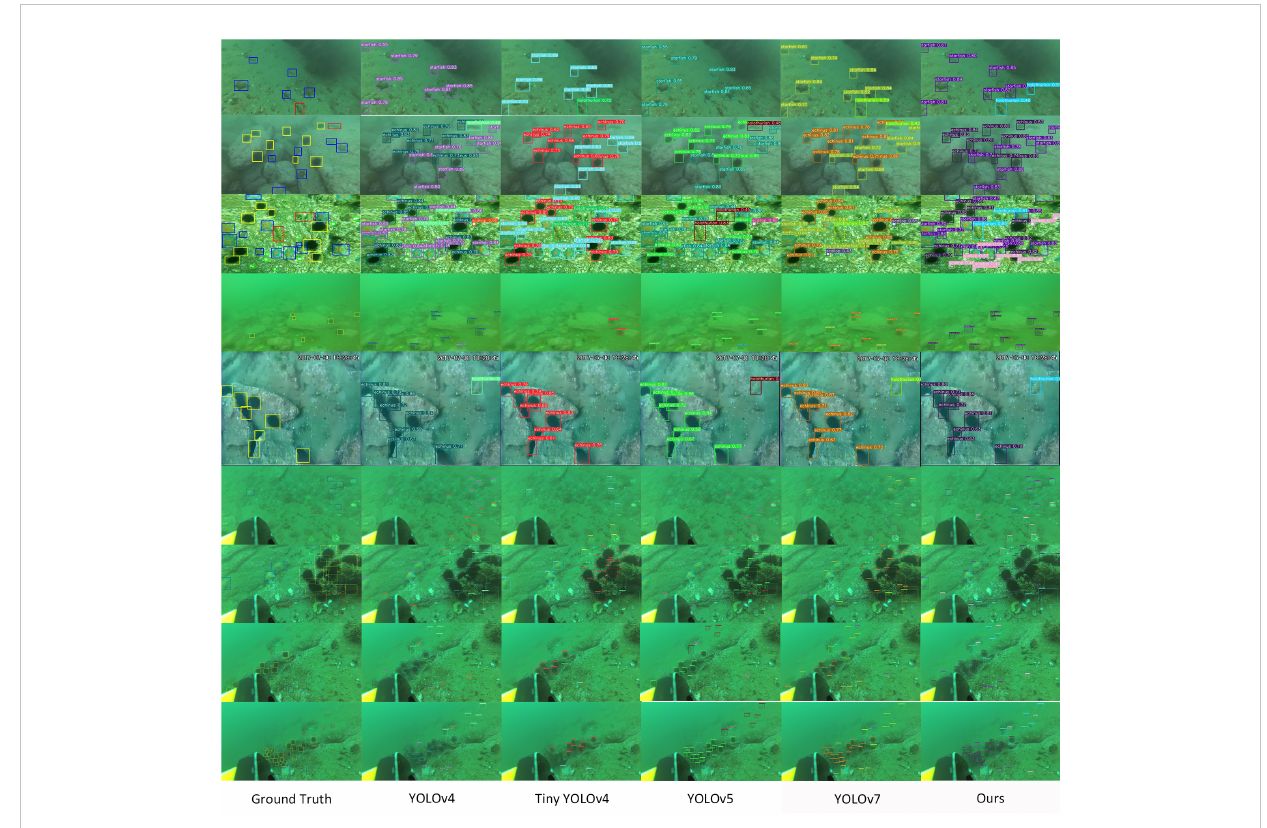
FIGURE 9 Visualization comparison of detection results with YOLO v4, Tiny YOLO v4, YOLOv5, YOLOv7, and ours.